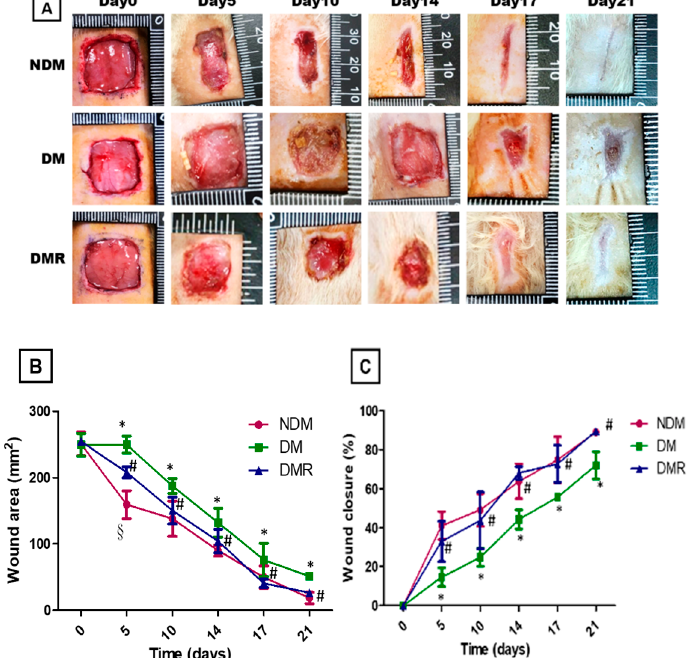
Figure 3. Continuous monitoring of 15 mm wound closure in each group over 21 days ( A ). The wound area ( B ) and wound closure ( C ) were calculated with NIH Image J analyzer by tracing the wound margin and calculating the pixel area. * p < 0.05 DM compared with the NDM group, § p < 0.05 DMR compared with the NDM group, # p < 0.05 DMR compared with the DM group.